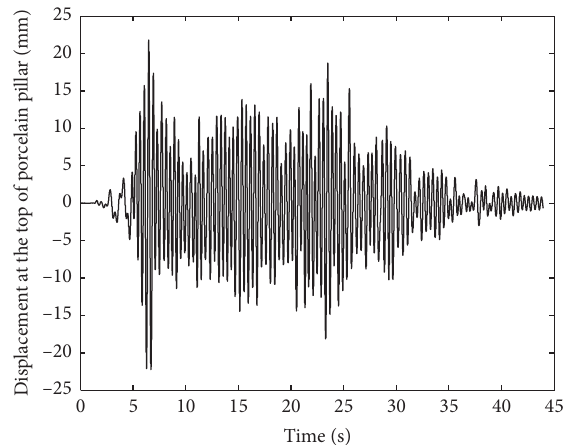
Figure 14: Displacement at the top of porcelain pillar ( a � 0.1g, η � 0).